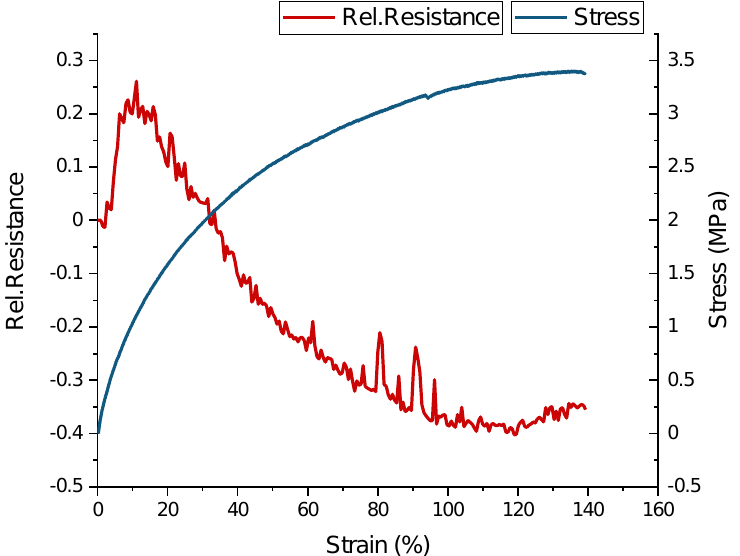
Figure 5. Mechanical and electrical behavior of the ShSF during a tensile test to the point of fracture.